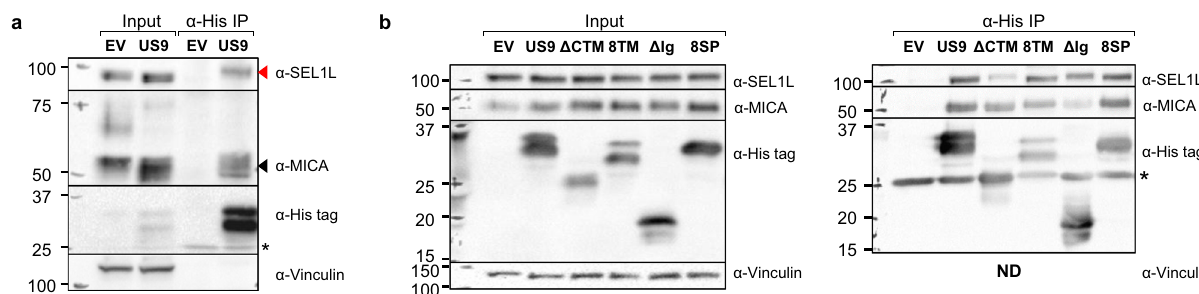
Fig. 6 The US9 Ig-like and transmembrane domains, but not the US9 SP, bind MICA*008, and the ERAD scaffold protein SEL1L. a Lysates prepared from RKO MICA*008-HA cells co-transduced with EV or US9 were immunoprecipitated using anti-His tag antibody. Immunoblotting was performed using anti-His tag, anti-MICA, and anti-SEL1L to visualize protein co-precipitation, with anti-vinculin as input loading control. Arrows indicate bands which speci fi cally co-precipitated with US9 (red — SEL1L; black — MICA*008). * antibody light chain. Representative of three independent experiments. b Lysates prepared from the indicated RKO MICA*008-HA transfectants were immunoprecipitated using anti-His tag (A — input; B — IP) and immunoblotted using anti-His tag, anti-MICA, and anti-SEL1L. Anti-vinculin served as input loading control. * antibody light chain. Representative of two independent experiments. ND not detected. See also Fig. S6 and Supplementary